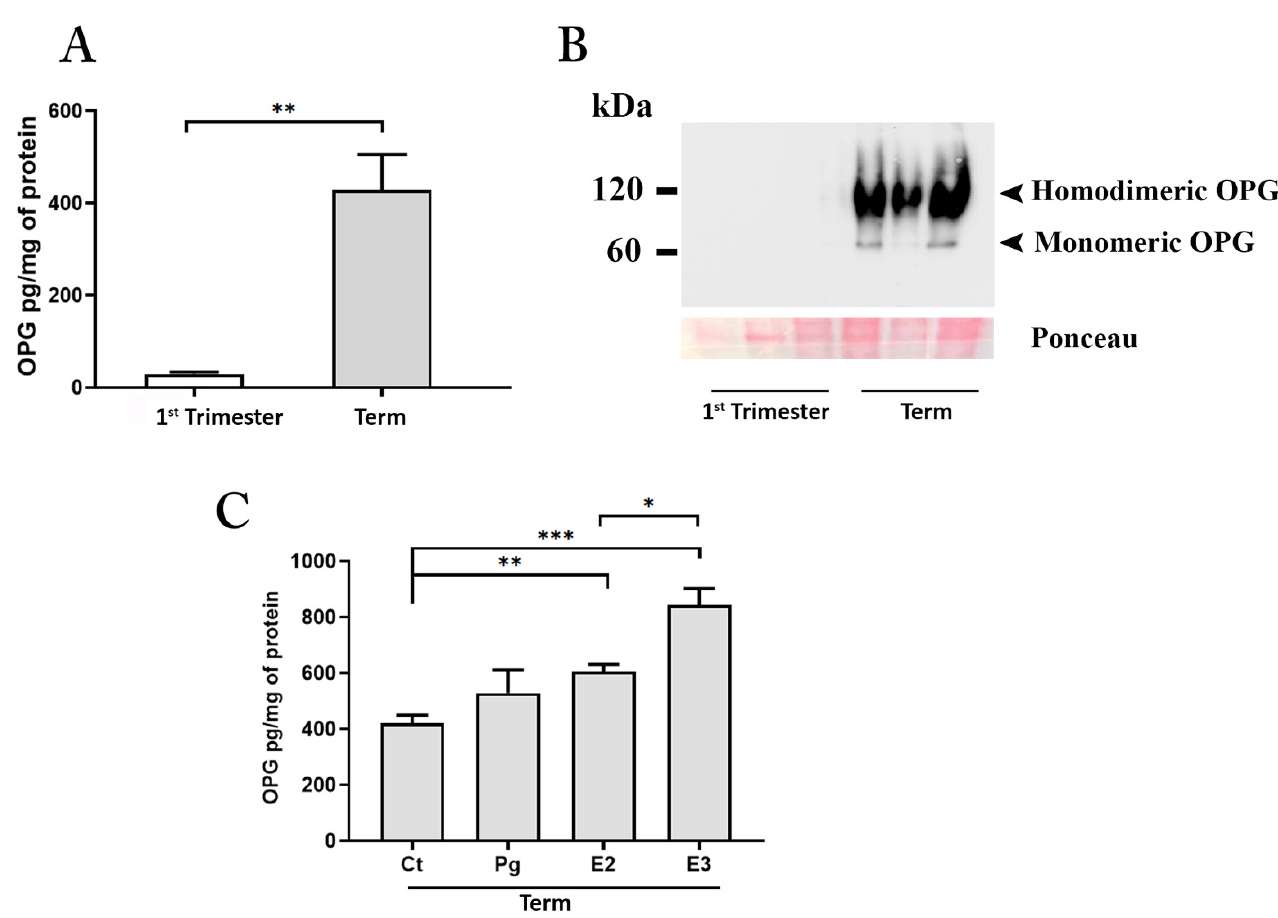
Figure 3. OPG production by placenta explants. ELISA assay for OPG in conditioned media ( A ) from first-trimester (maintained at 3% of oxygen for 48 h; n = 4 placentae at 9–11 weeks) and term (maintained at 8% of oxygen; n = 6 placentae at 38–39 weeks) placenta explants. Representative Western blot ( B ) under non-reducing conditions for OPG in conditioned media from first-trimester and term placenta explants. ELISA assay for OPG in conditioned media ( C ) from term placenta explants (maintained at 8% of oxygen; n = 3 placentae at 38–39 weeks) exposed for 48 h to estradiol (E2, 1 × 10 − 8 M), estriol (E3 7 × 10 − 8 M) and progesterone (Pg, 1 × 10 − 6 M) or medium alone (control, Ct). Data expressed as mean ± SEM. Significance was determined with the Unpaired t -test for OPG production in basal condition and one-way ANOVA for hormones exposure experiments. * p < 0.05; ** p < 0.01; *** p < 0.001.